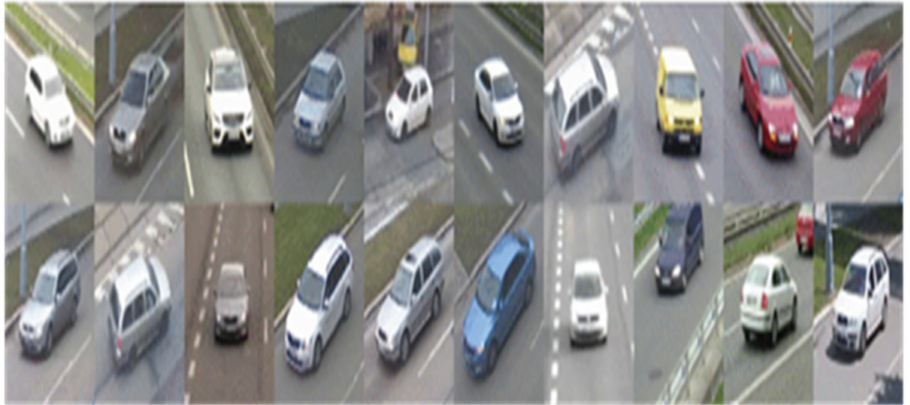
Figure 22. Depicts the sample images of BoxCar21k dataset.